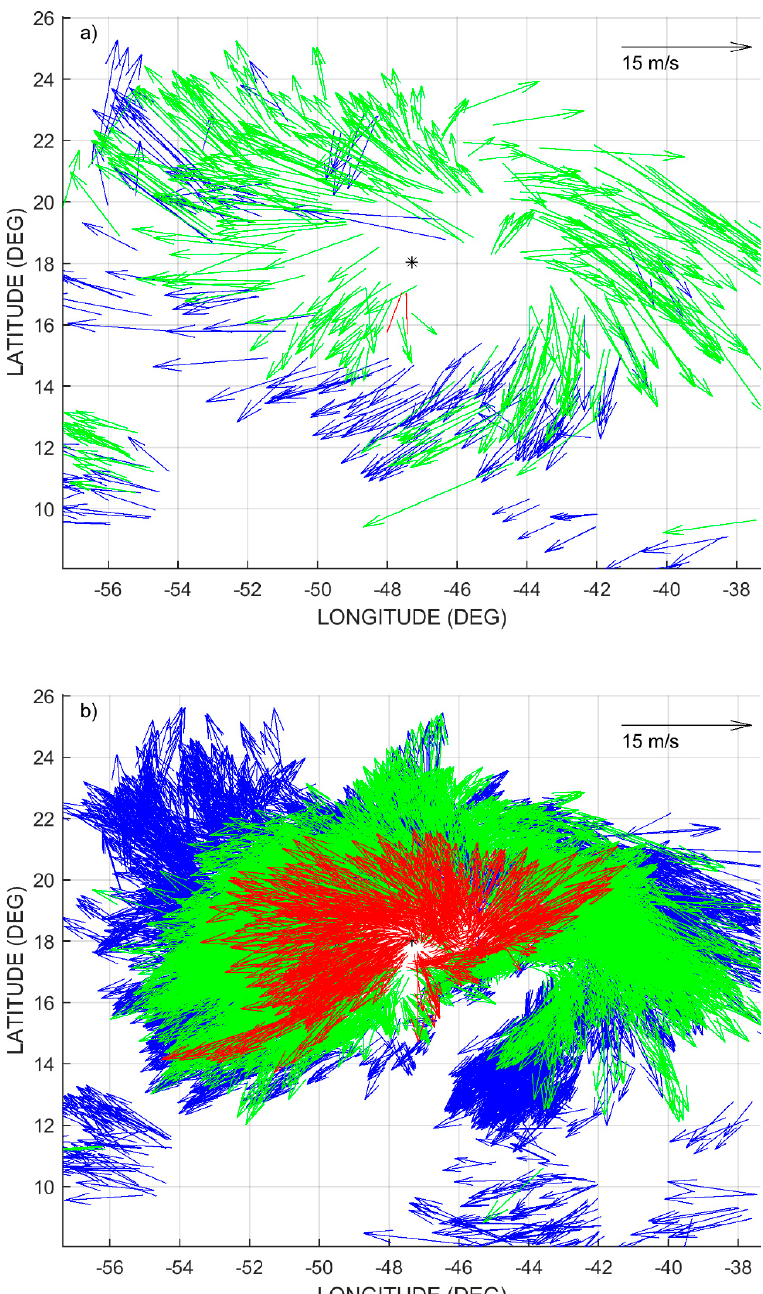
Figure 1. ( a ) Internal CIMSS hourly AMVs from GOES-13 at 0900 UTC 3 September relative to the Hurricane Irma position (asterisk) with green (blue) vectors between 150 and 200 mb (200 and 250 mb). ( b ) As in panel ( a ), except for CIMSS 15 min AMVs from GOES-16 at 0915 UTC 3 September with addition of AMVs above 150 mb in red vectors.